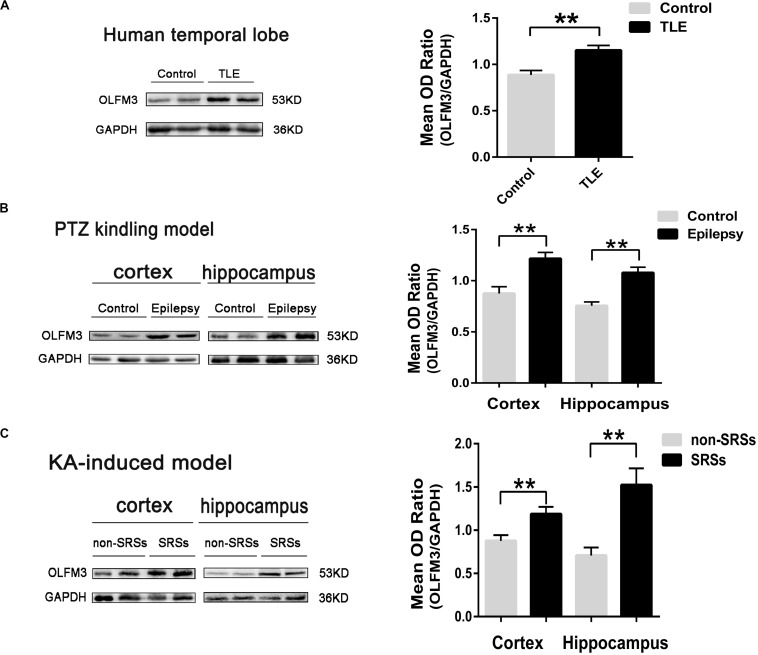
Increased OLFM3 expression in patients with TLE and the two mouse models. (A) Representative Western blots showing significantly increased OLFM3 expression in the cortex of patients with TLE (n = 24) compared with controls (n = 12) (**P < 0.01). (B) OLFM3 expression levels were significantly increased in the cortex and hippocampus of PTZ-kindled epileptic mice compared with control mice (n = 5 per group; **P < 0.01). (C) OLFM3 expression was significantly higher in the cortex and hippocampus of the spontaneous seizure group induced by KA than the non-spontaneous seizure group (n = 5 per group; **P < 0.01). All expression levels of OLFM3 were normalized by calculating the OD ratio of OLFM3 to GAPDH (OLFM3/GAPDH).